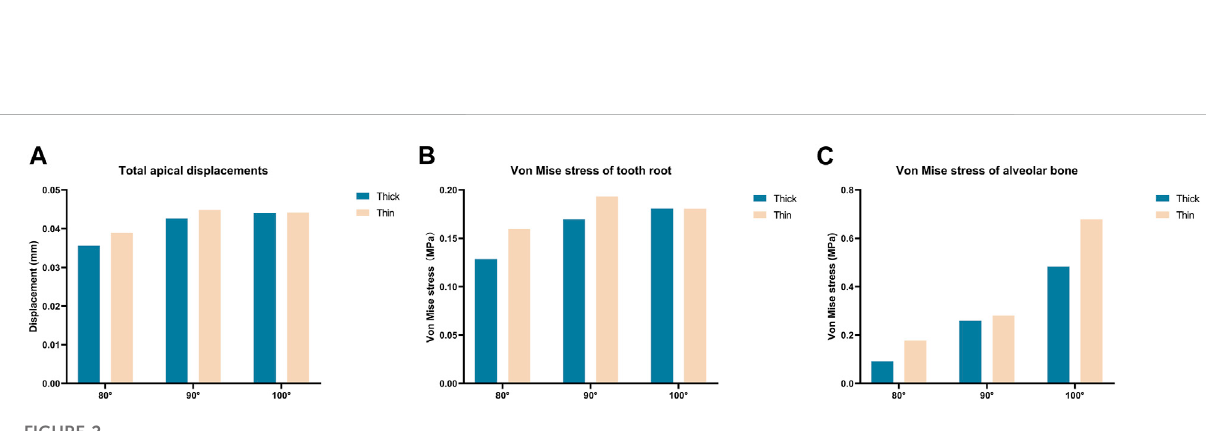
stress and strain of the alveolar crest were shown in Figure 6. The extent of stress and strain in both the thick and thin biotypes were concentrated in the mesial-labial alveolar crest. A line chart was